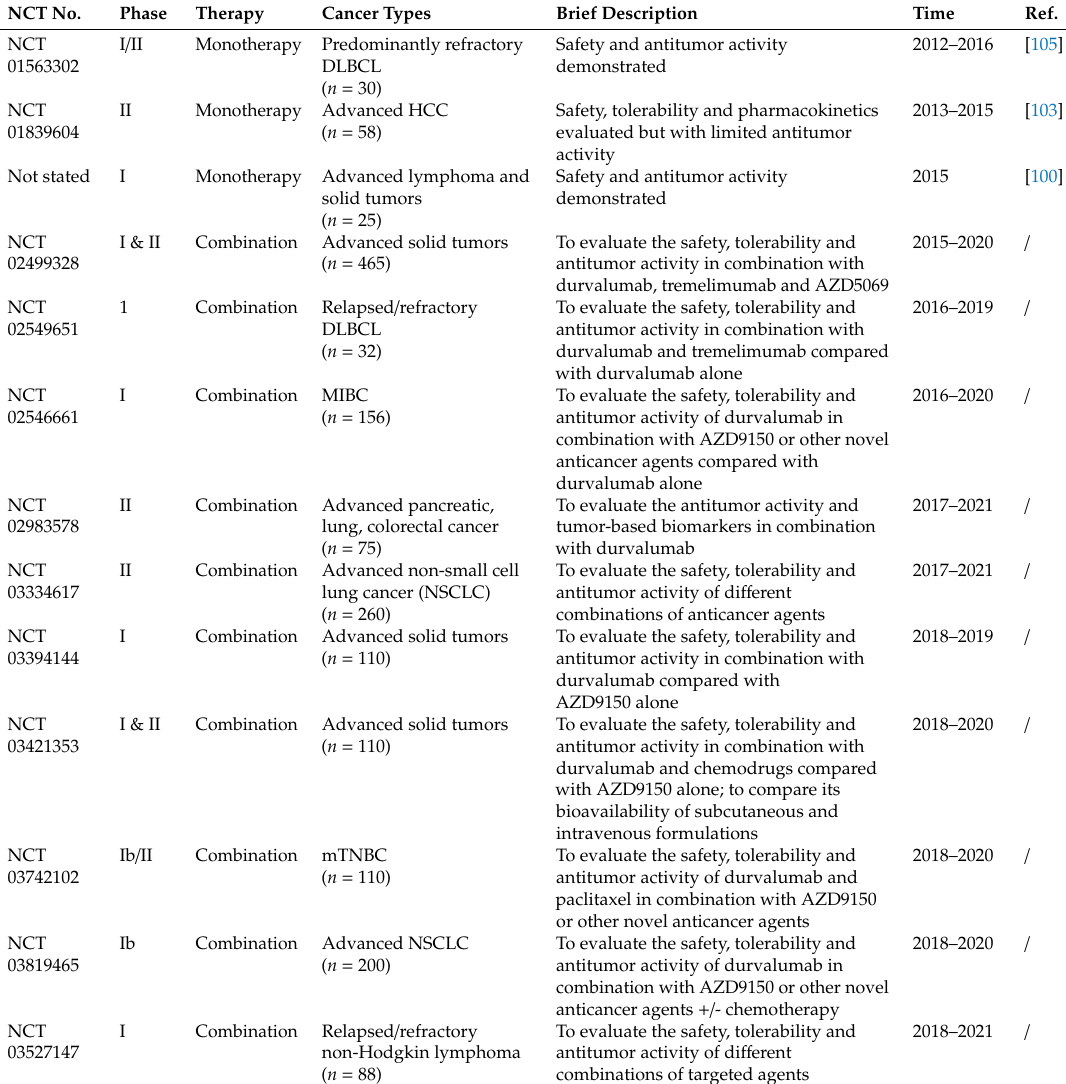
Table 2. Clinical trials of AZD9150: STAT3-targetd antisense oligonucleotide. NCT